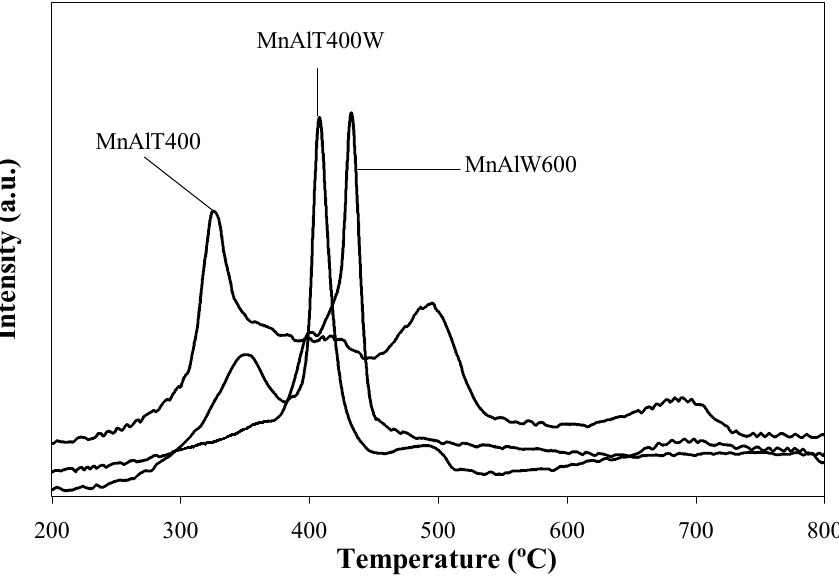
Figure 8. Samples characterization by H